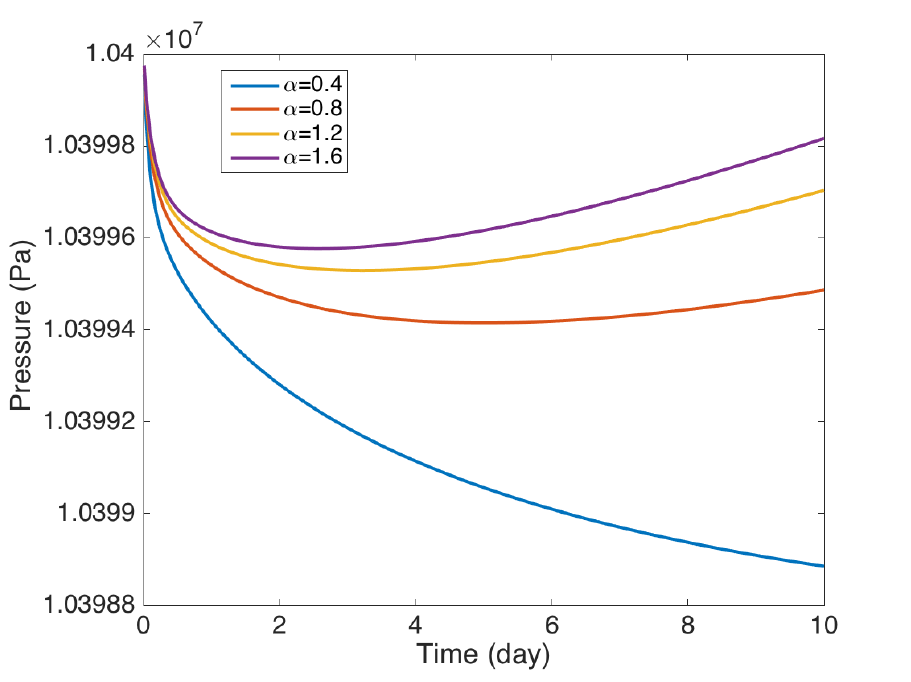
Figure 9. The average pressure for various values of the parameter α